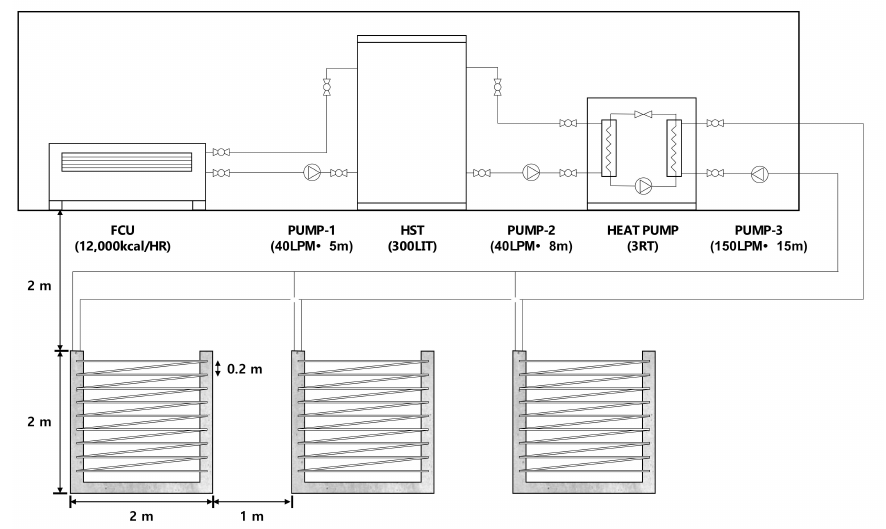
Figure 9. Schematic of GSHP system for the prototype of modular